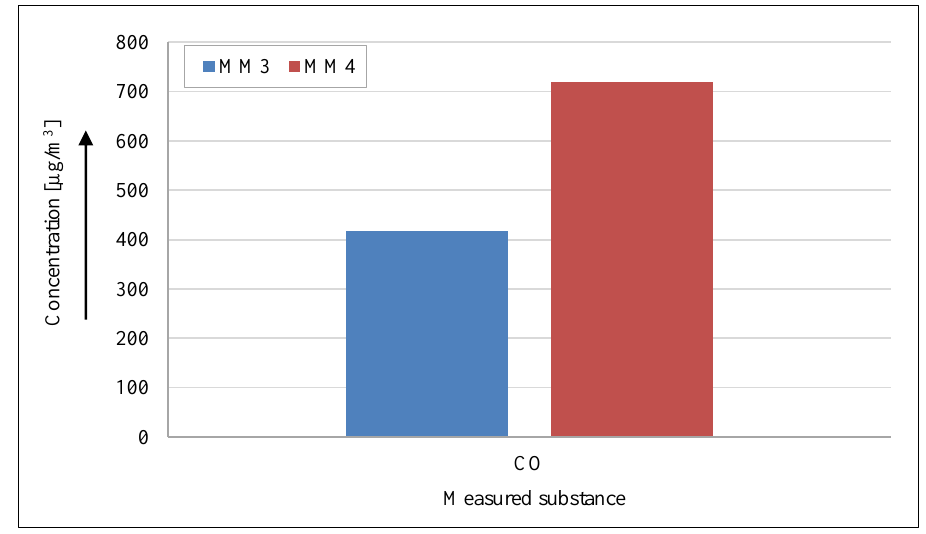
Figure 9. The concentration of CO measured